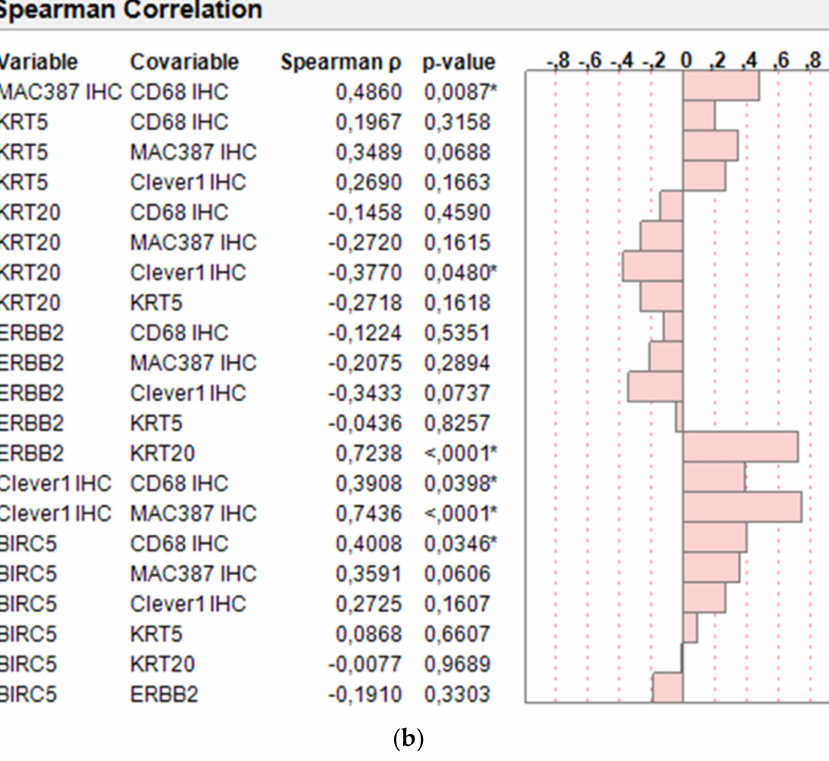
Figure 4. ( a ) Correlation of normalized KRT5 , KRT20 , ERBB2 , BIRC5 , and CD68 mRNA levels in the PCR cohort ( n = 39) of bladder cancer patients treated with adjuvant chemotherapy. Graphical display of Spearman rho values and respective p-values are depicted. * indicates statistically significant results; ( b ) Correlation of KRT5 , KRT20 , ERBB2 , and BIRC5 mRNA levels with protein levels of CD68, MAC387, and CLEVER-1 determined by IHC in the combined PCR and IHC cohort ( n = 28) of bladder cancer patients treated with adjuvant chemotherapy. Graphical display of Spearman rho values and respective p-values are depicted. * indicates statistically significant